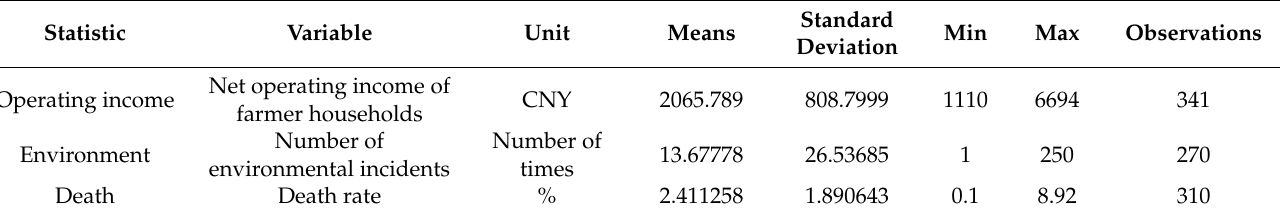
Table 5. Descriptive statistics of surrogate